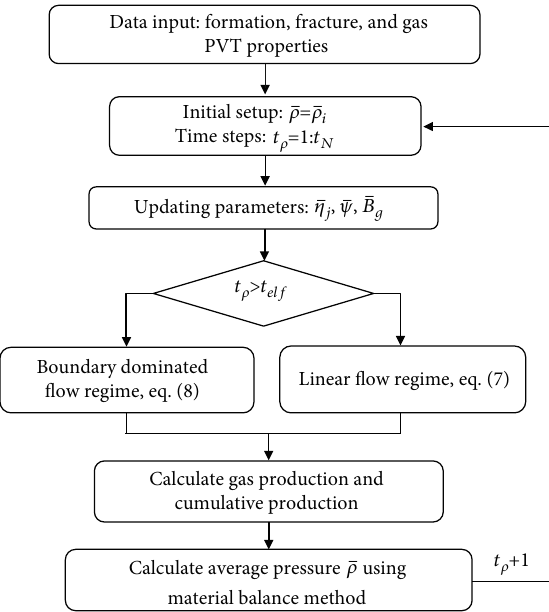
Figure 3: The procedure to predict the production for a single- linear fl ow